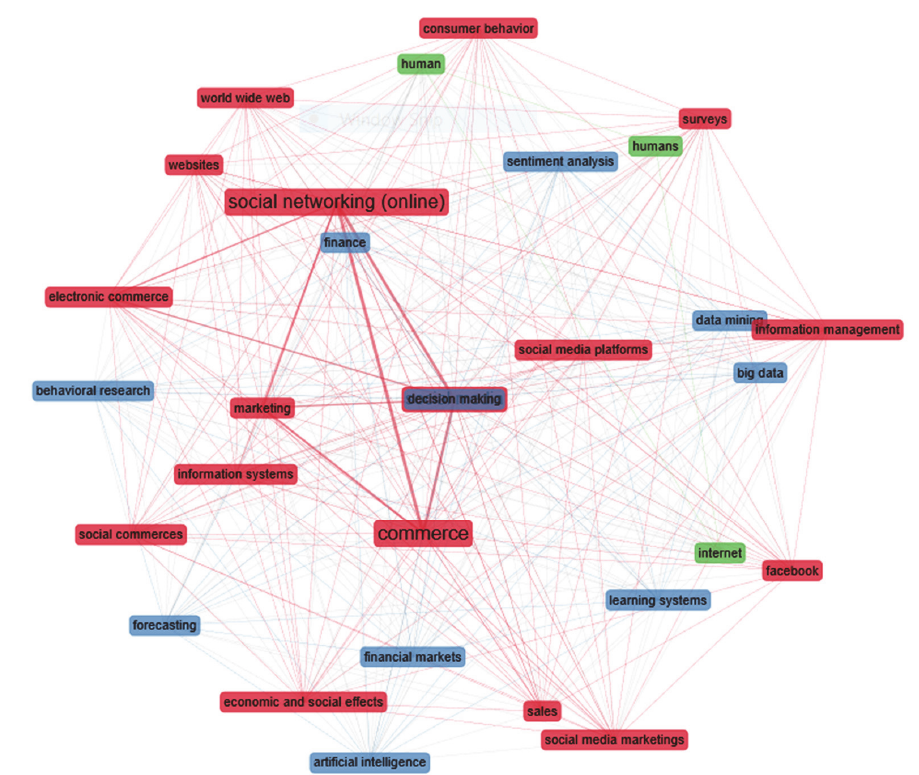
Fig. 4. Co-occurrence network